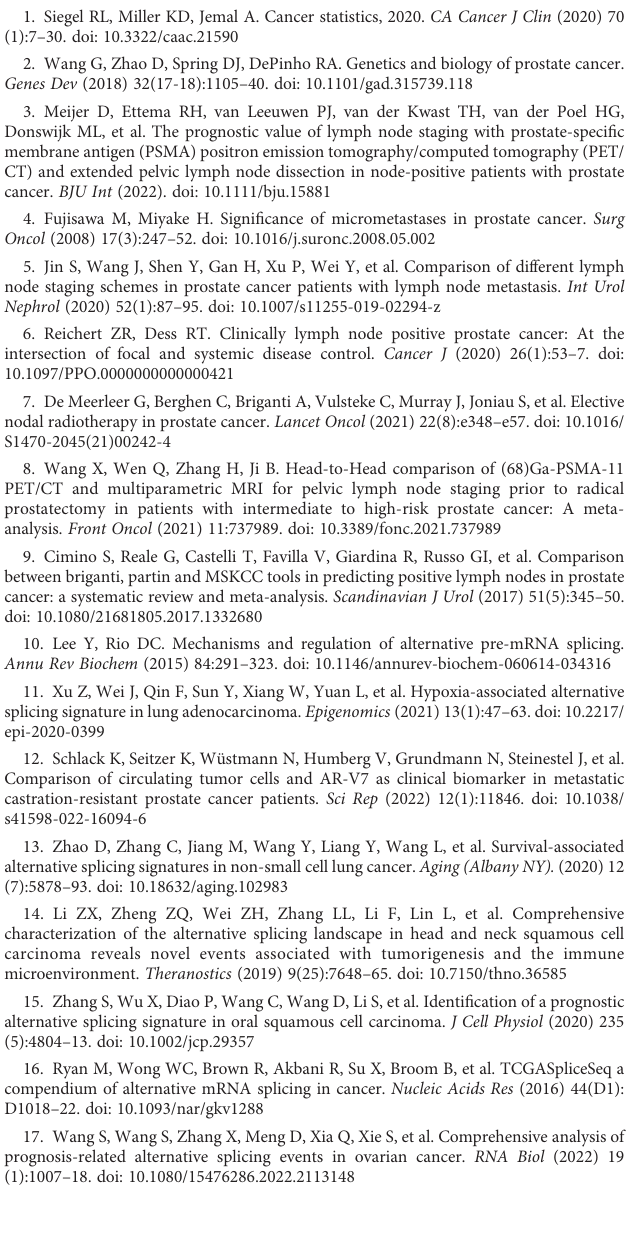
SUPPLEMENTARY FIGURE 1 Overview of seven types of AS events pro fi ling in the PRAD patients. (A) UpSet plot of intersections among seven types of AS events in the PRAD patients. (B) Number of AS events and corresponding parent genes in the PRAD patients. (C) Pie chart of composition ration of seven AS events in the